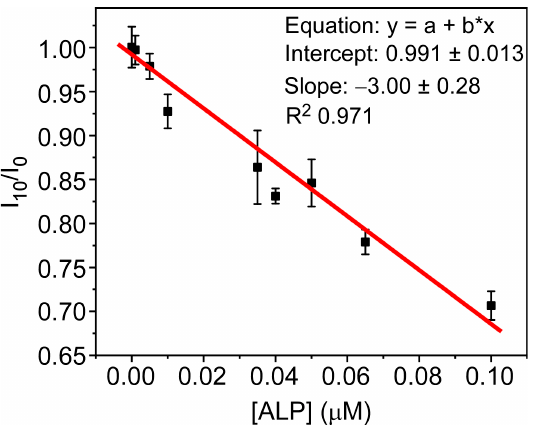
Figure 9. ALP calibration curve and fit parameters. Fluorescence quenching was measured 10 min after the addition of each ALP concentration (I t = 10 /I t = 0 ) to partially rehydrated PNPP@PFO@AETA xerogels. Error bars represent the standard deviation of three replicates.